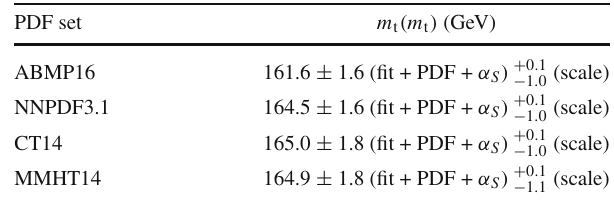
Table 5 Values of α S ( m Z ) with their uncertainties obtained from a comparisonofthemeasured σ tt valuetotheNNLOpredictionintheMS schemeusingdifferentPDFsets.Thefirstuncertaintyisthecombination of the experimental and PDF uncertainties, and the second is from the variation of the renormalization and factorization scales